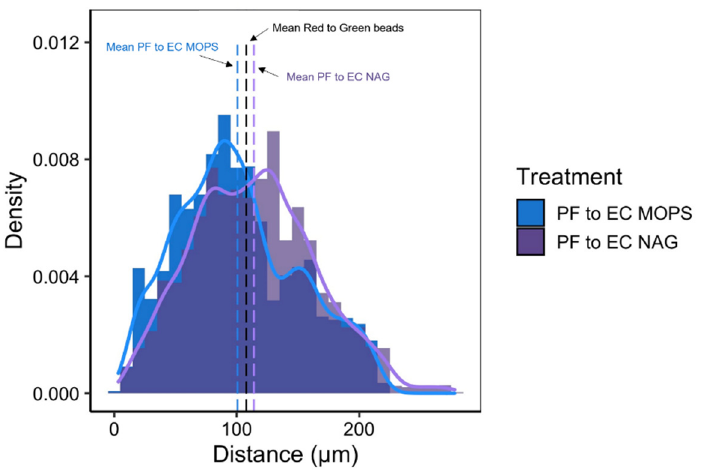
Figure 6. Histogram of P. fluorescens GFP (PF) to E. coli RFP (EC) cell distances within single SSAs surrounded by MOPS-only media (MOPS) or MOPS media containing 4-methylumbelliferyl N-acetyl- β -D-glucosaminide (NAG). Dashed lines represent the mean distance for MOPS (blue), NAG (purple), and fluorescent bead reference image (black).